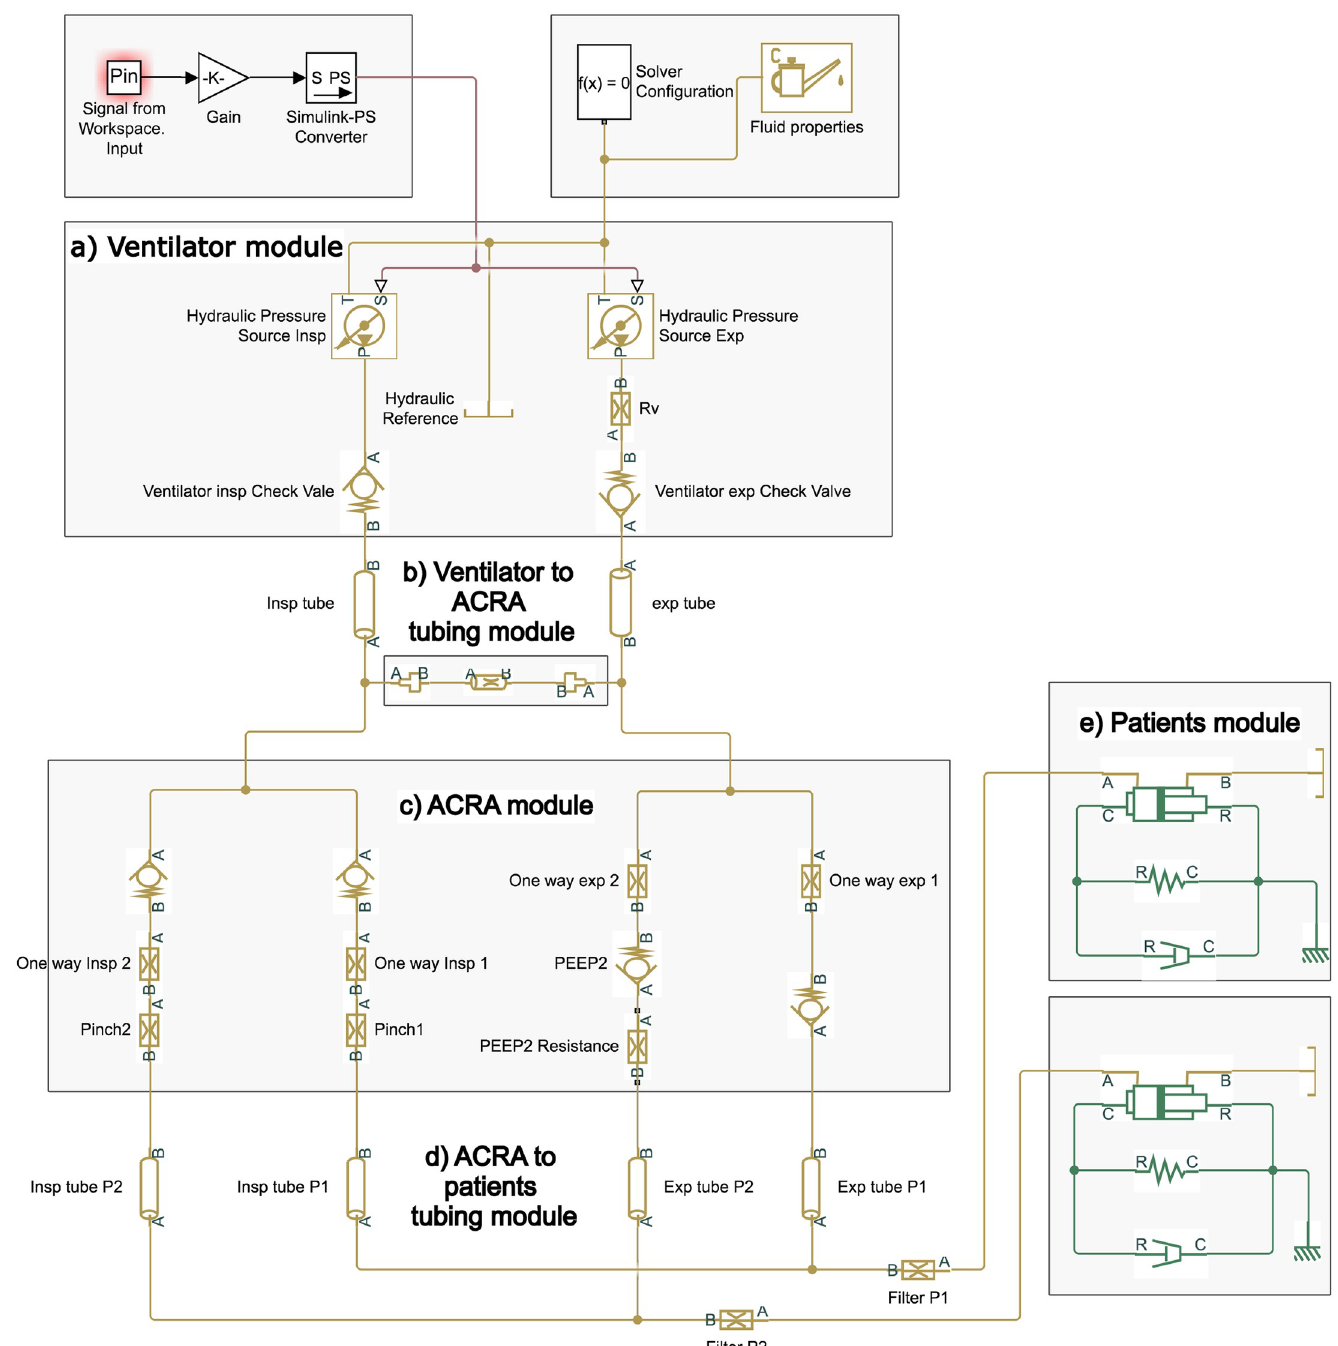
Fig 4. Simulink scheme of the ACRA